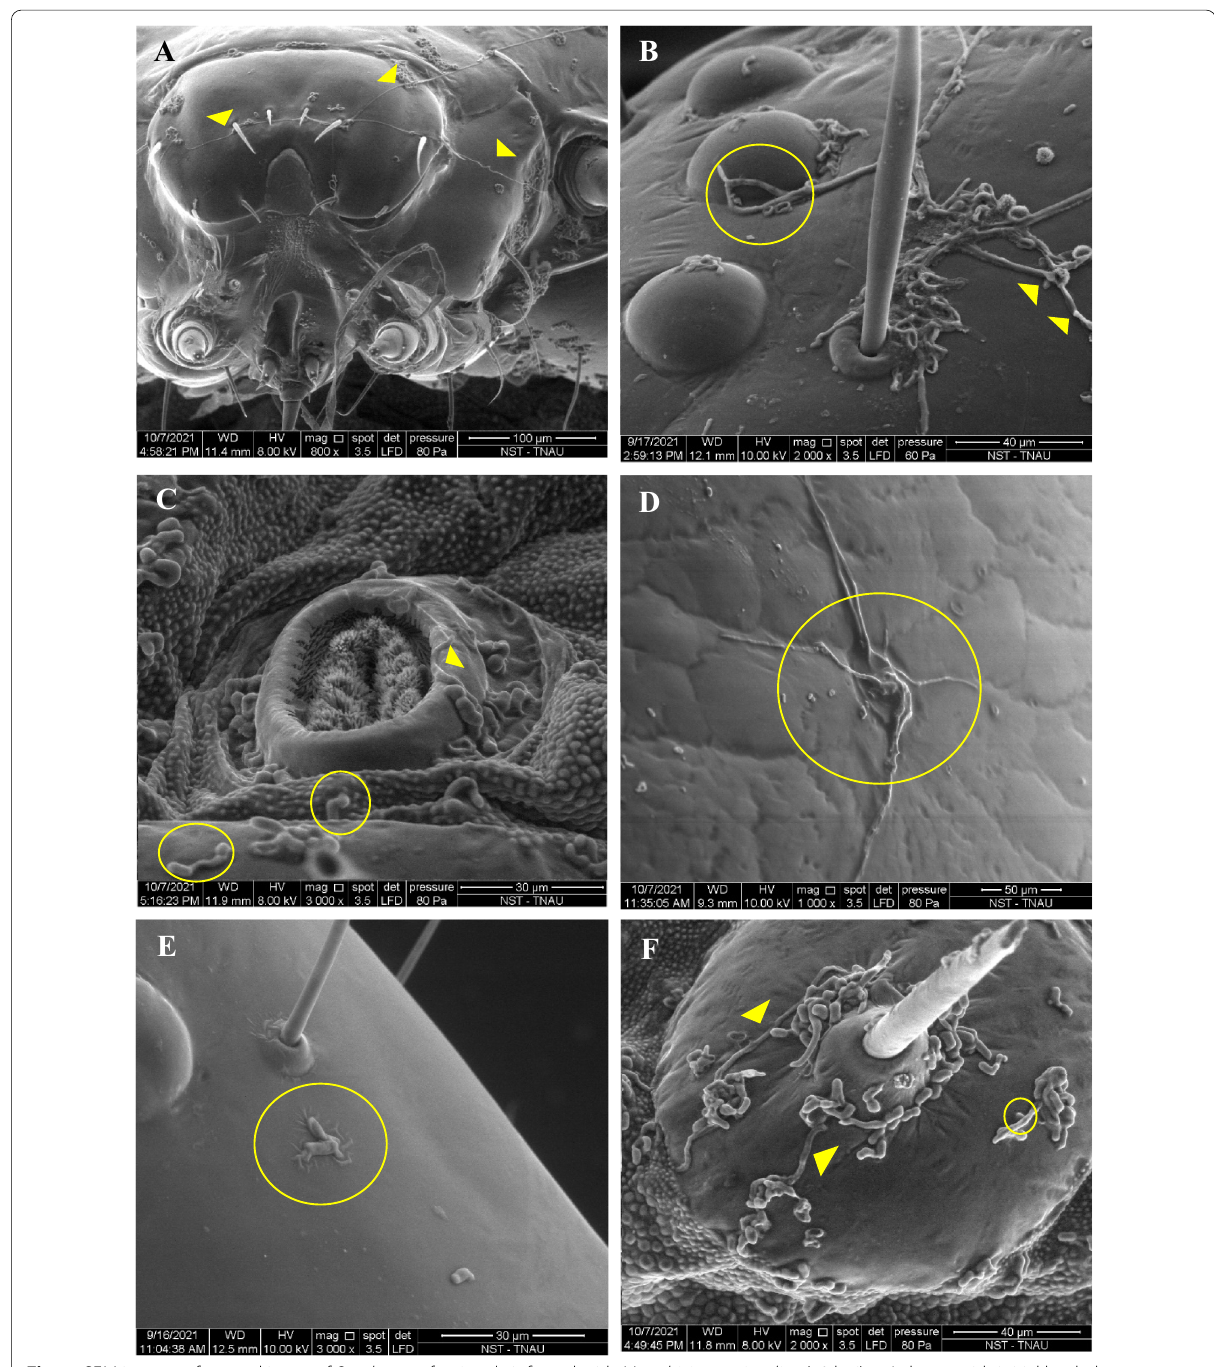
Fig. 5 SEM images of second instar of Spodoptera frugiperda infected with Metarhizium anisopliae (72 hpi). a . Labrum with initial hyphal development (arrowhead). b . Hyphae with appressorium (arrow heads) around stemmata region (circles). c . hyphal growth in spiracular region (arrowhead), germlings of conidia with germ tube and appressorium (circle). d . Hypha penetrating the cuticle (circle) e. penetration of hypha from conidia in head region (circle). f . Close-up of developing hyphal clusters around setal region (arrowheads), Hyphae with intercalary appressorium